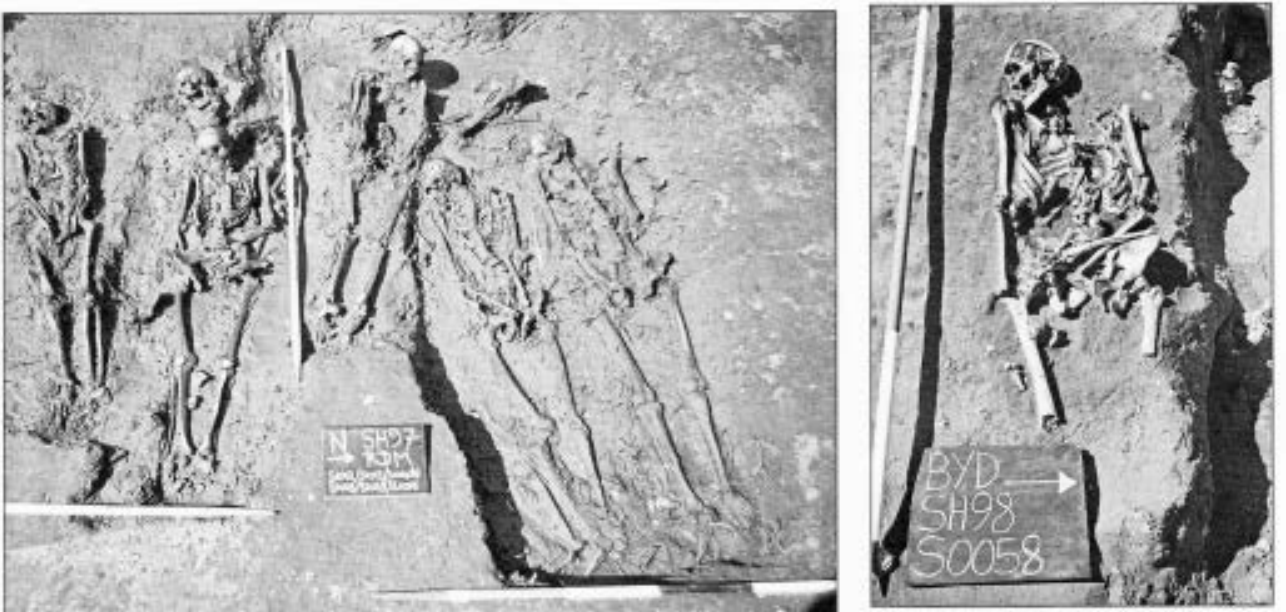
Figure 6 A boneyard burial truncated by a later